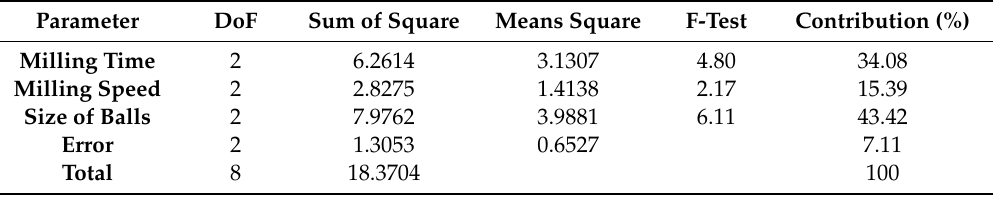
Table 5. Results of ANOVA approach to prepare POA